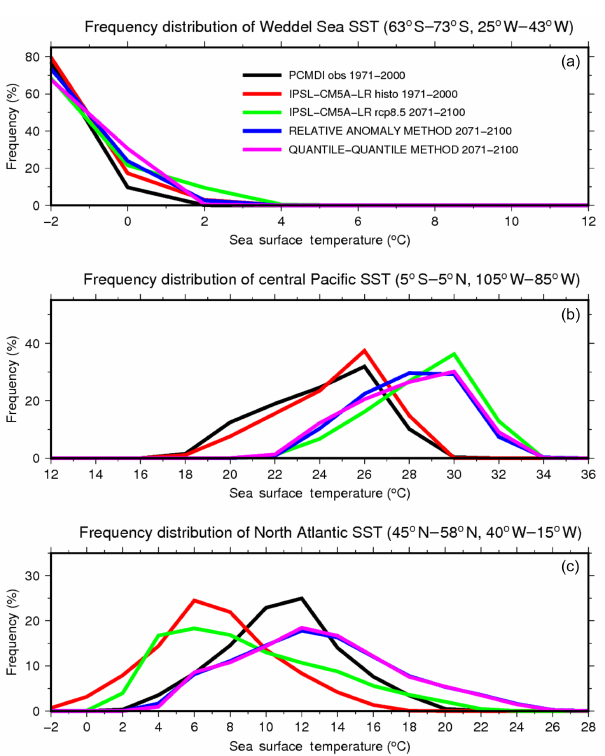
Figure 4. Frequency distribution of SST for PCMDI observa- tions (black), IPSL-CM5A-LR historical (red) over 1971–2000 and RCP8.5 (green), and quantile–quantile method (pink) and anomaly method (blue) applications over 2071–2100 for the Weddell Sea (a) , central Pacific (b) and North Atlantic (c)